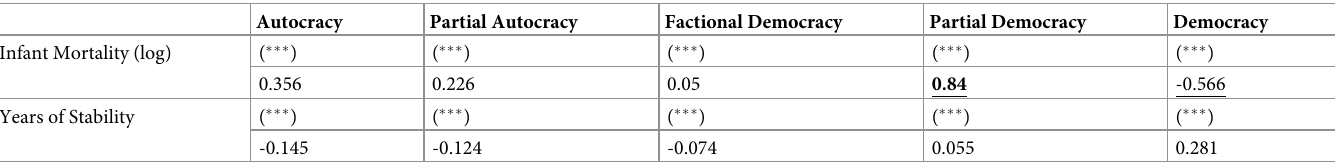
tions with infant mortality or years of stability , thereby justifying the inclusion of polity code in our models. Table B in S1 Text lists the correlations between all potential predictors and Table C in S1 Text lists the biserial correlations between the potential predictors and polity code. Table 4. Point biserial correlations between polity code and other selected